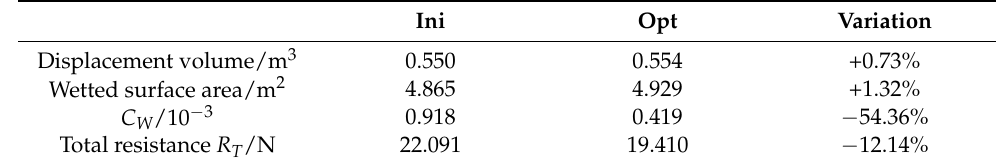
Table 6. Performance comparison of initial and optimized hull